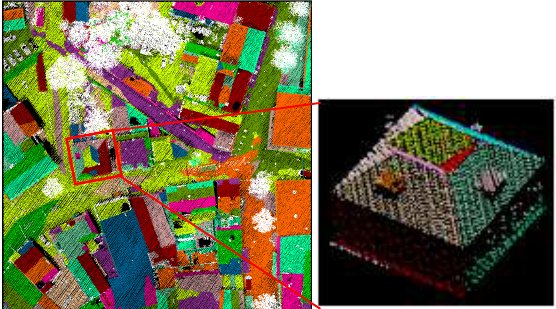
Figure 5. Segmentation result in Enschede site. (non-segmented points are represented in white)